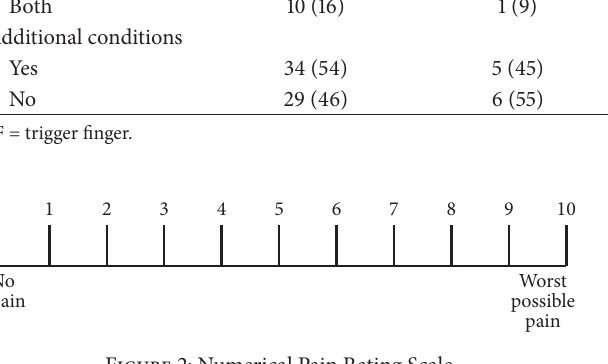
Figure 2: Numerical Pain Rating